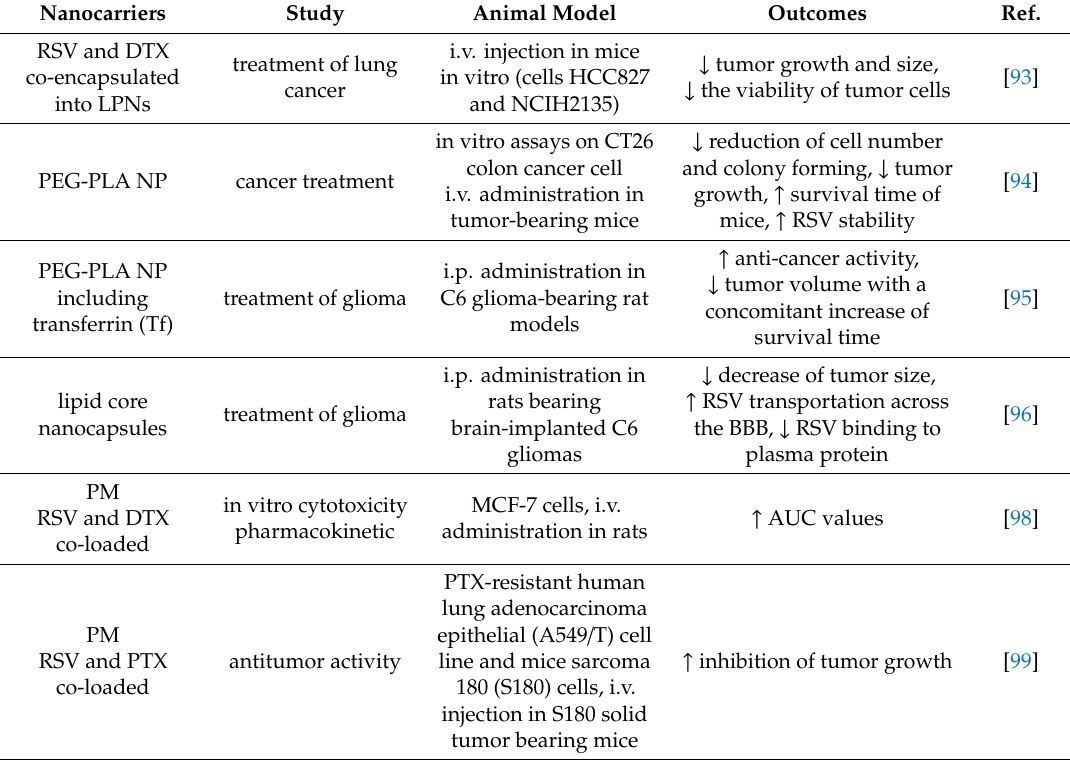
Table 3. Parental resveratrol (RSV) drug delivery systems. DTX = docetaxel; LPNs = lipid-polymer hybrid NP; NP = nanoparticles; PEG-PLA = polyethylene glycol - polylactic acid; i.v. = intravenous; i.p. intraperitoneal; BBB = blood brain barrier; PM = polymeric micelles; PCT = paclitaxel; (pHO-1) = heme oxygenase-1